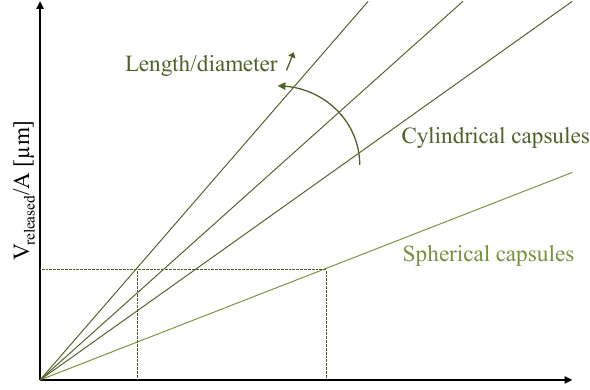
) per crack area ( A ) as a function of Figure 5. Released volume of healing agent (V released the capsule concentration for spherical and cylindrical capsules with a different length to diameter ratio. The horizontal and vertical crossing lines indicate the magnitude of the effect when changing from spheres to cylindrical capsules with a high length to diameter ratio (redrafted after